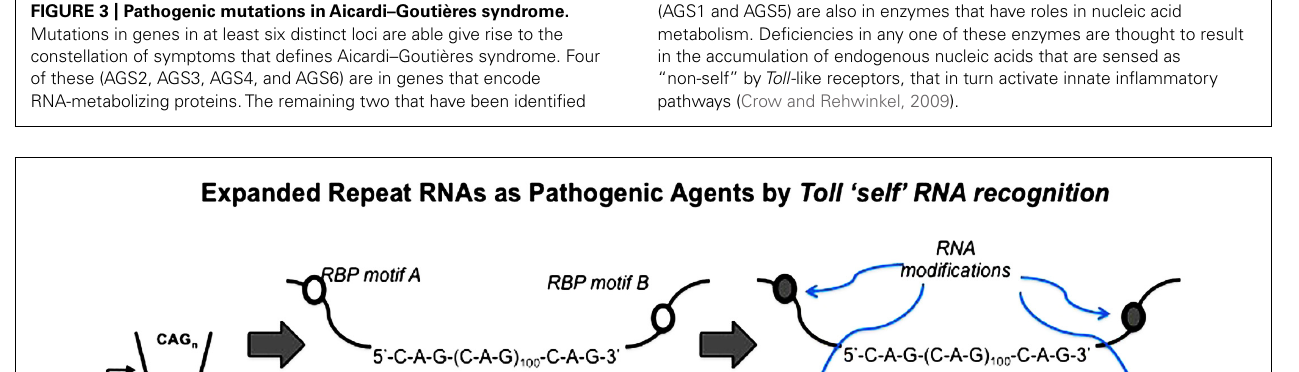
(AGS1 and AGS5) are also in enzymes that have roles in nucleic acid metabolism. Deficiencies in any one of these enzymes are thought to result in the accumulation of endogenous nucleic acids that are sensed as “non-self” by Toll -like receptors, that in turn activate innate inflammatory pathways (Crow and Rehwinkel, 2009).